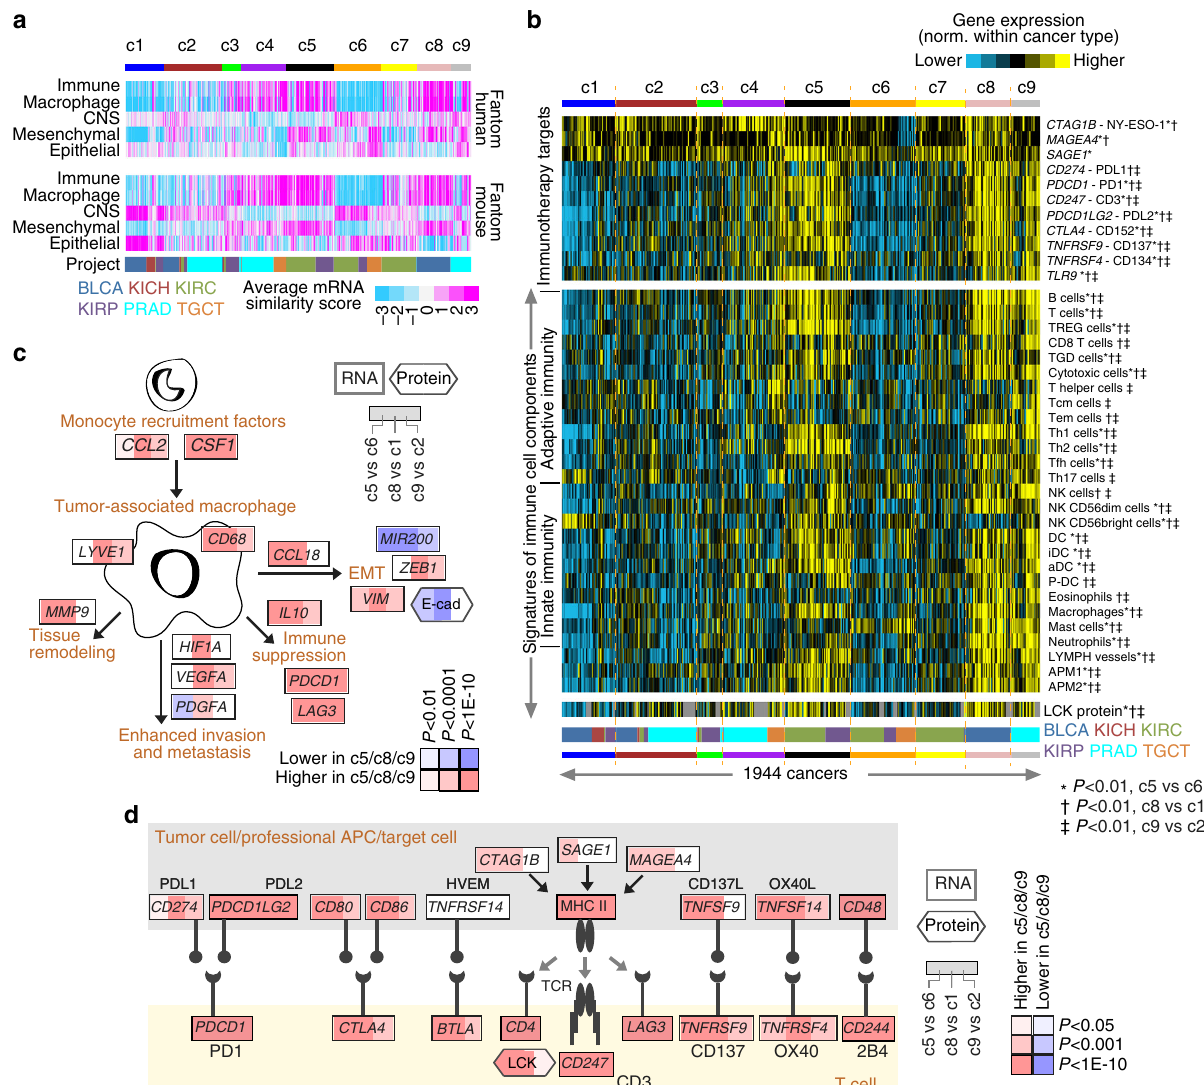
Fig. 6 Macrophage- and immune checkpoint-related differences across pan-urologic genomic subtypes. a Average expression similarity correlation (Pearson ’ s t -statistic, based on genes in Fig. 1b; pink , positive or similar; blue , negative or dissimilar) between TCGA urologic cancer subtypes (columns) and fantom 27 cell types or tissues in selected categories (rows): “ immune, ” immune cell types or blood or related tissues; “ CNS, ” related to central nervous system including brain; “ macrophage, ” “ mesenchymal, ” “ epithelial, ” denoting fantom pro fi les for samples including one of these keywords. Results shown for both fantom human and fantom mouse data sets. For “ immune, ” “ macrophage ” , and “ mesenchymal ” correlations, differences are signi fi cant with P < 1E- 10 ( t -test), when comparing c5 with c6 cases, comparing c8 with c1 cases, and comparing c9 with c2 cases. b Heat maps of differential expression, for genes encoding immunotherapeutic targets ( top panels ) and for gene expression-based signatures 34 of immune cell in fi ltrates ( bottom panels ), across TCGA urologic cancer subtypes (expression values normalized within cancer type). TREG cells regulatory T cells, TGD cells T gamma delta cells, Tcm cells T central memory cells, Tem cells T effector memory cells, Tfh cells T follicular helper cells, NK cells natural killer cells, DC dendritic cells, iDC immature DCs, aDC activated DCs, P-DC plasmacytoid DCs, APM1/APM2 antigen presentation on MHC class I/class II, respectively. c Diagram of tumor-associated macrophage roles in the tumor microenvironment 35 , with differential expression patterns represented, comparing tumors in groups c5, c8, or c9 with tumors in groups c6, c1, or c2, respectively ( red , signi fi cantly higher in c5/c8/c9). P -values by t -test. d Diagram of immune checkpoint pathway (featuring interactions between T cells and antigen-presenting cells, including tumor cells), with differential expression patterns represented, comparing tumors in groups c5, c8, or c9 with tumors in groups c6, c1, or c2, respectively ( red , signi fi cantly higher in c5/c8/c9). P -values by t -test. See also Supplementary Fig.